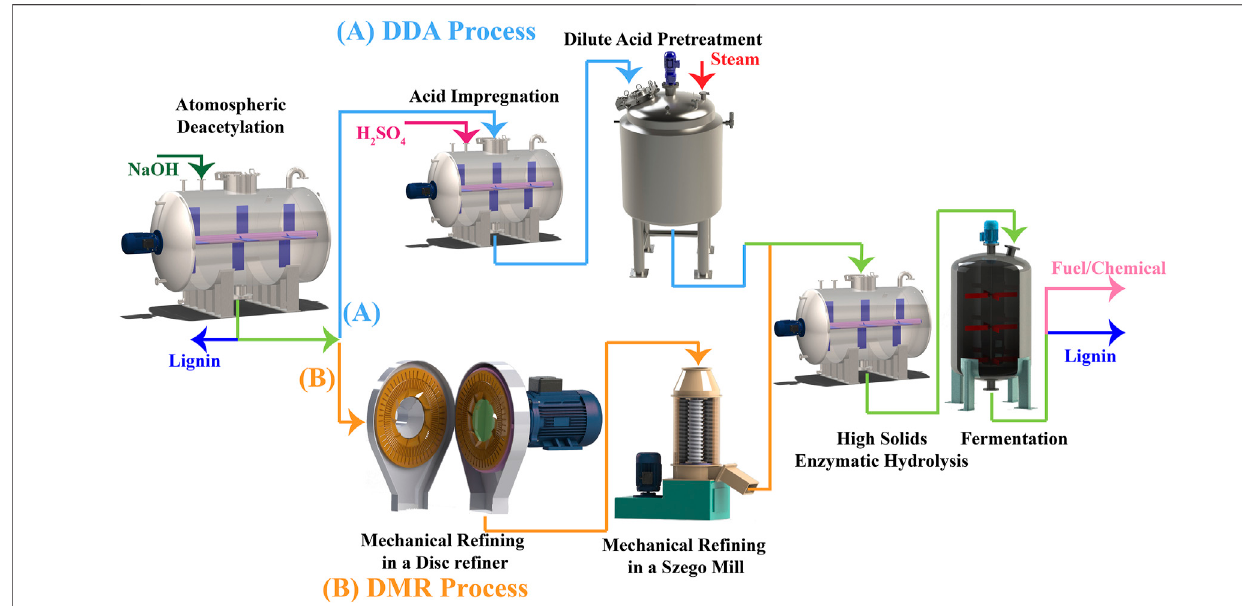
FIGURE 1 | Illustration of different pretreatment pathways: (A) the DDA process and (B) the DMR process.